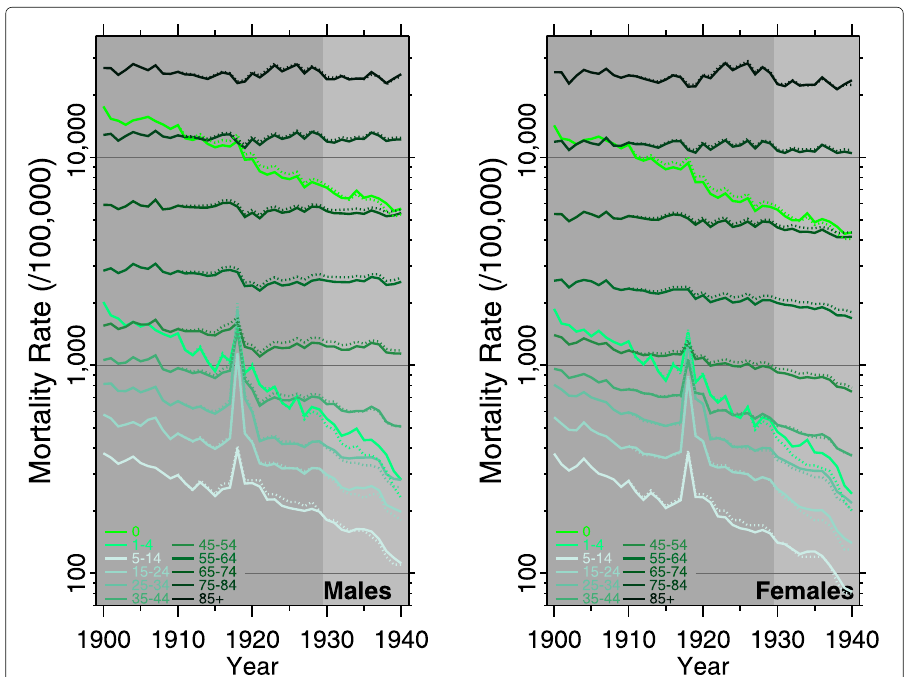
Fig. 6 Mortality rates by age, 1900–1940, whites. Solid lines are for the death registration area (1900–1932) and USA (1933–1940); dotted lines are for the death registration states of 1910 (1910–1940). Darker shading denotes input data to Lee-Carter model (up to 1929), but note that 1918 is excluded from the input data